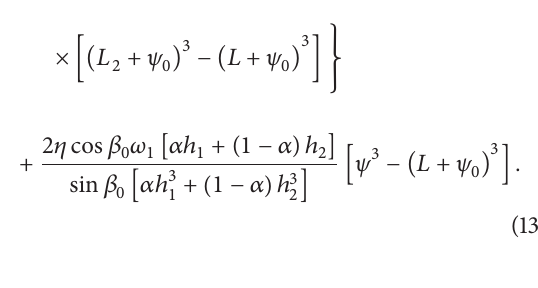
Figure 5: Radial step of the external pumping